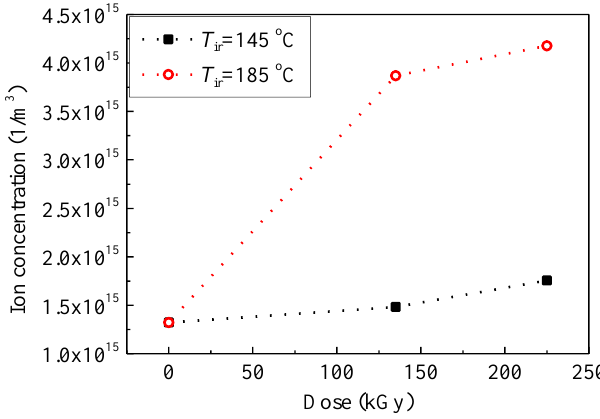
Figure 10. Ion concentration measured at 200 °C as a function of dose at T ir of 145 and 185 °C.